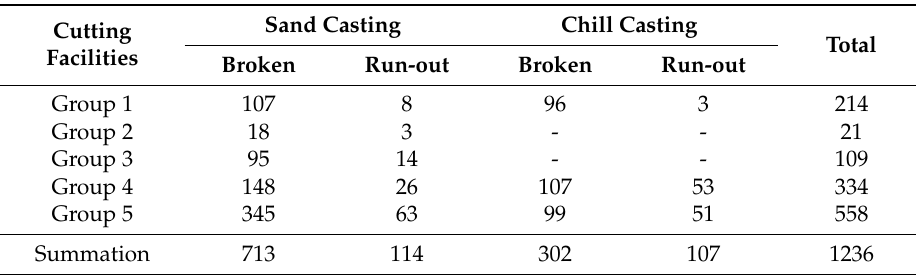
Table 9. Number of test results by cutting facilities.